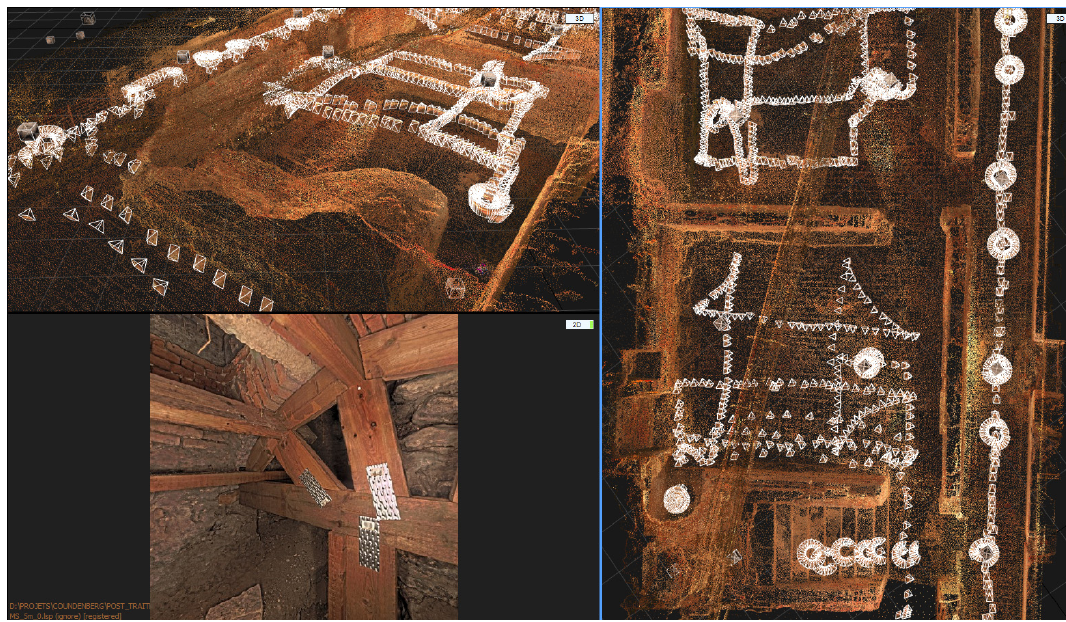
Figure 17. Registration of different photos with laser ‐ scanning data. In white, the different positions of the pictures.